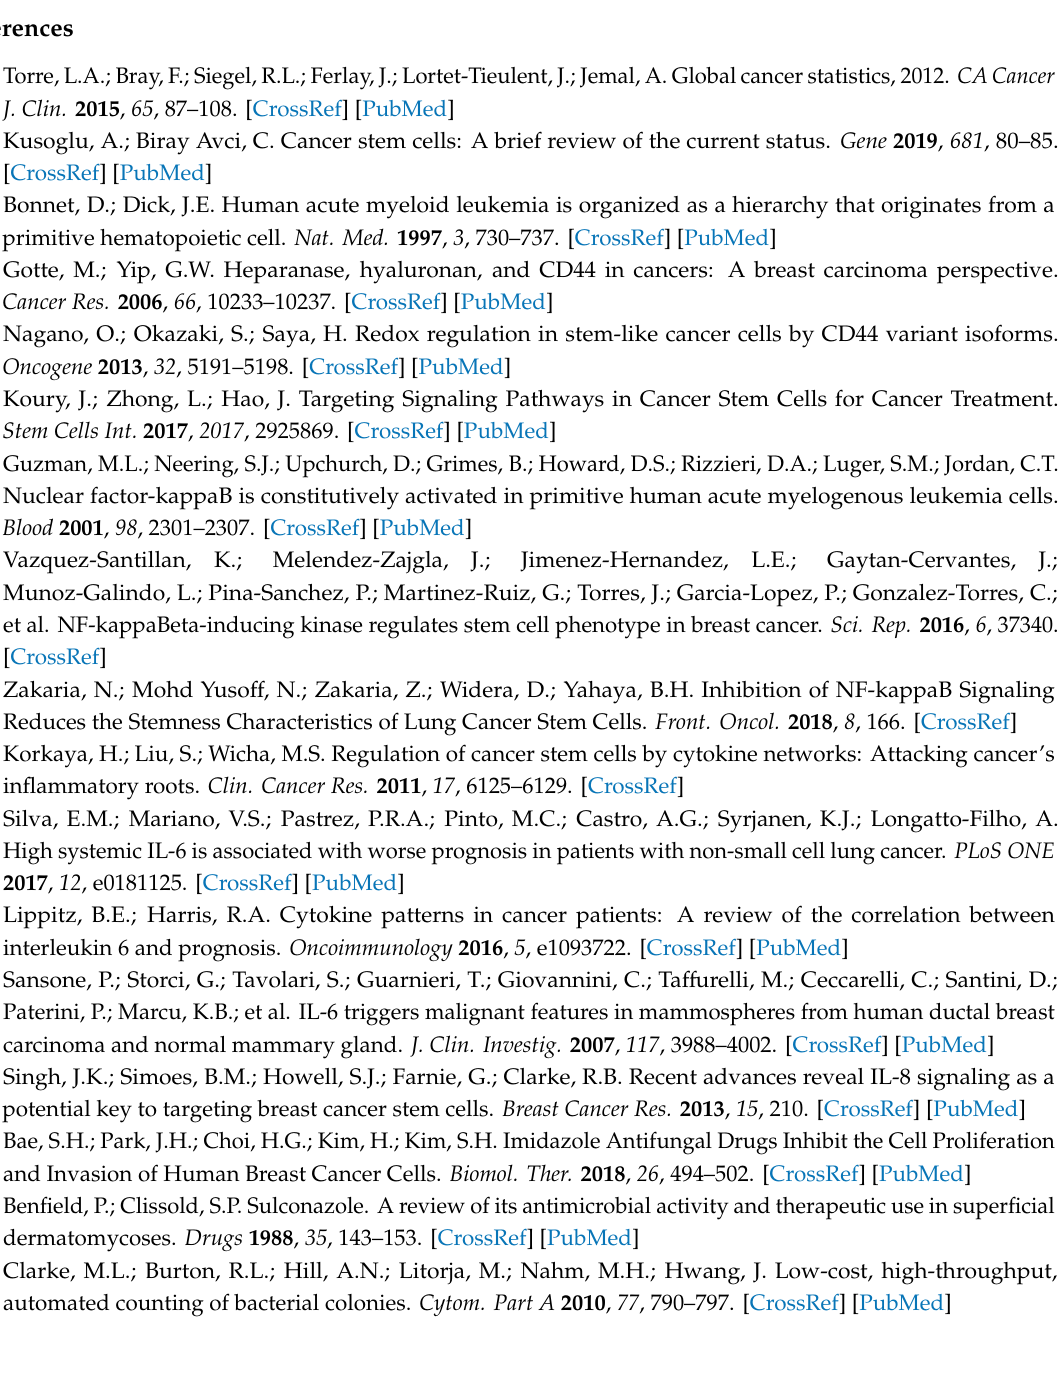
Supplementary Table S1. Specific primer sequences for real-time